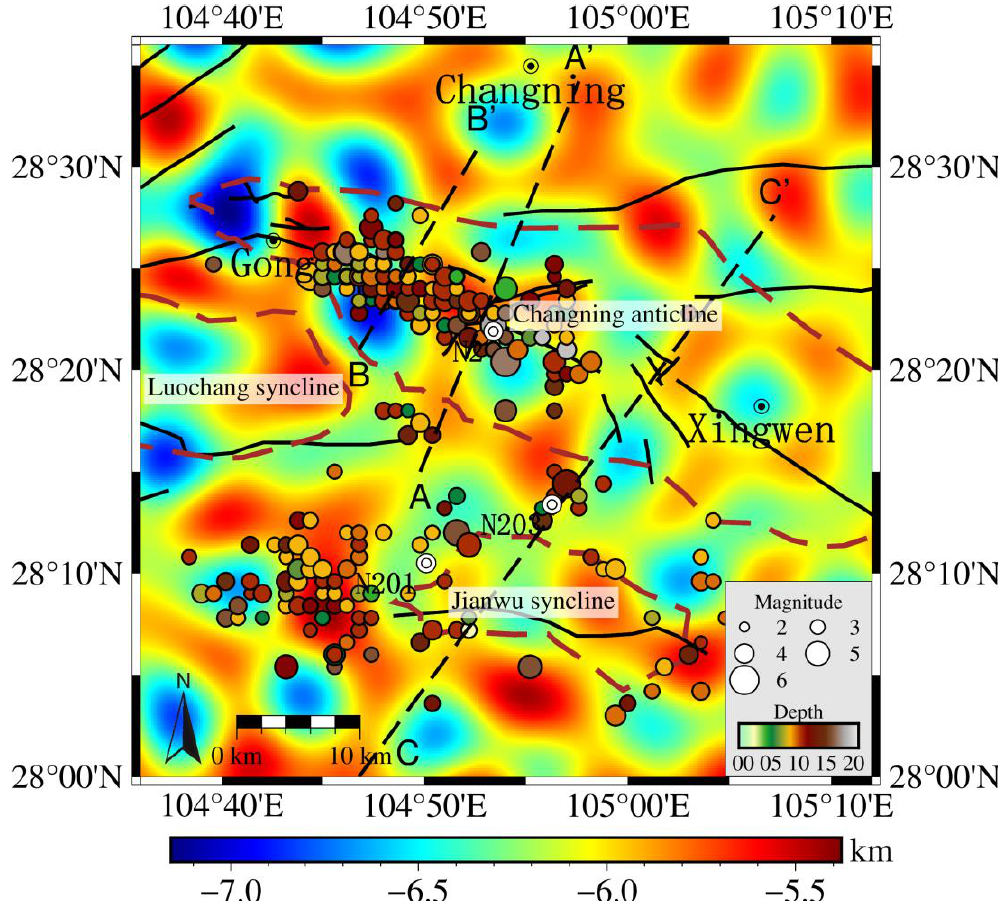
Figure 6. Estimated magnetic basement relief map of the Changning area. The black dotted lines show the location of the three high-resolution seismic reflection profiles from the study by Lu et al. [13]. The magnitudes and depths of earthquakes are shown in the lower right corner.